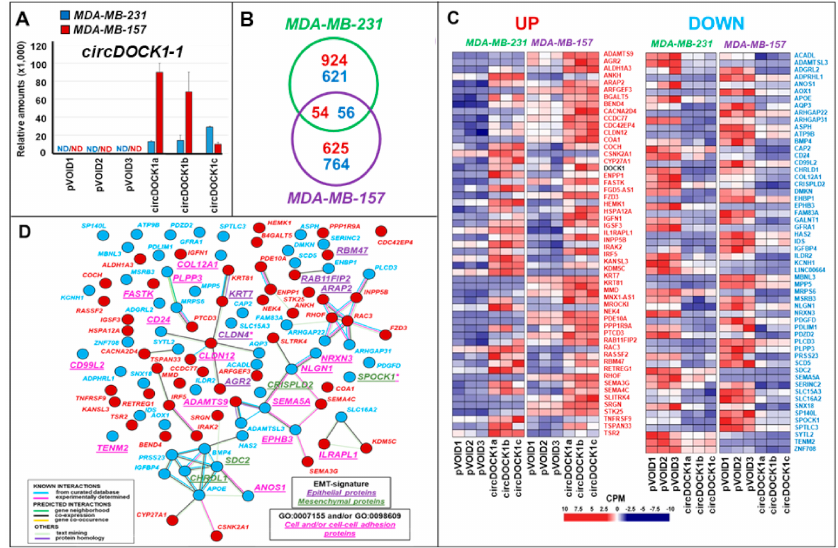
Figure 3. Transcriptomic effects of circDOCK1-1 overexpression in MDA-MB-231 and MDA-MB-157 cells. Three independent MDA-MB-231 and MDA-MB-157 cell clones stably transfected with the circDOCK1-1 expression plasmid ( circDOCK1a ; circDOCK1b ; circDOCK1c ) and the corresponding empty vector ( pVOID1 ; pVOID2 ; pVOID3 ) were isolated and used for the experiments presented in the various panels of the figure. ( A ) The column graph shows the levels of the circDOCK1-1 RNA determined by RT-PCR analysis of the total RNA extracted from the indicated cell populations using a specific Taqman assay. ND = not detectable. ( B ) The Venn diagram shows the number of genes significantly up- and downregulated by circDOCK1-1 overexpression in MDA-MB-231 and MDA-MB-157 cells. Upregulated genes are marked in red and downregulated genes are marked in blue, as indicated. ( C ) The heat maps show the expression levels of the indicated genes measured in 3 independent clones of MDA-MB-157 and MDA-MB-231 cells transfected with a plasmid construct, allowing the expression of the circDOCK1-1 RNA and the corresponding void vector. The results were obtained using RNA-seq following isolation of total RNA and are expressed in CPM (Counts Per Million reads). The levels of DOCK1 are shown and marked in black, as they represent an internal control of the experiment. In fact, the DOCK1 reads are expected to increase in circDOCK1-1 infected cells. ( D ) The panel shows the interactomic network of the proteins whose coding transcripts are upregulated (red circles) and downregulated (blue circles) in both MDA-MB-231 and MDA-MB-157 cells overexpressing circDOCK1-1 . The proteins marked in violet are predominantly expressed in breast cancer tissues and cells characterized by an epithelial phenotype, while those marked in green are predominantly expressed in the mesenchymal counterparts, as indicated. The proteins involved in cell adhesion are marked in pink. The type of predicted interactions among the various proteins is also indicated by the coloured lines. CLDN * = CLDN is both an epithelial protein as well as a cell and cell/cell adhesion protein. SPOCK1 * = SPOCK1 is both a mesenchymal protein as well as a cell and cell/cell adhesion